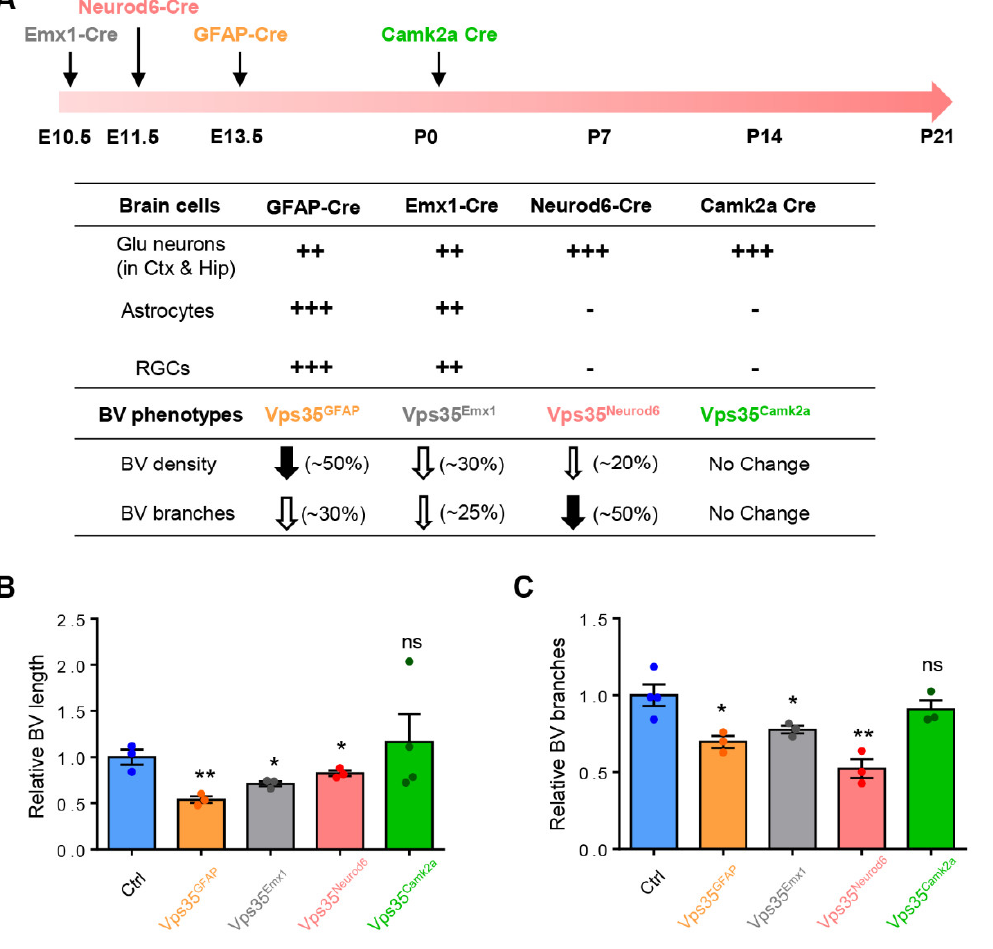
Figure 2. Quantification of BV length and branches of different Cre lines. ( A ) Time graph illustrating the efficiency time and space of the Emx1-Cre, Neurod6-Cre, GFAP-Cre, and Camk2a-Cre lines that were used to delete Vps35 in the embryonic and perinatal NSCs and NPCs, as well as BV phenotypes in corresponding conditional knockout mice with different Cre lines. ( B ) Summary of relative BV length in conditional knockout mice with different Cre lines (n = 3 mice per genotype; two-tailed unpaired t test). ( C ) Summary of relative BV branches in conditional knockout mice with different Cre lines (n = 3 mice per genotype; two-tailed unpaired t test). Individual data points are shown as dots with group mean ± SEM; * p < 0.05; ** p < 0.01; ns., not significant. ++, +++: The different amount of Cre expression in indicated cell types.